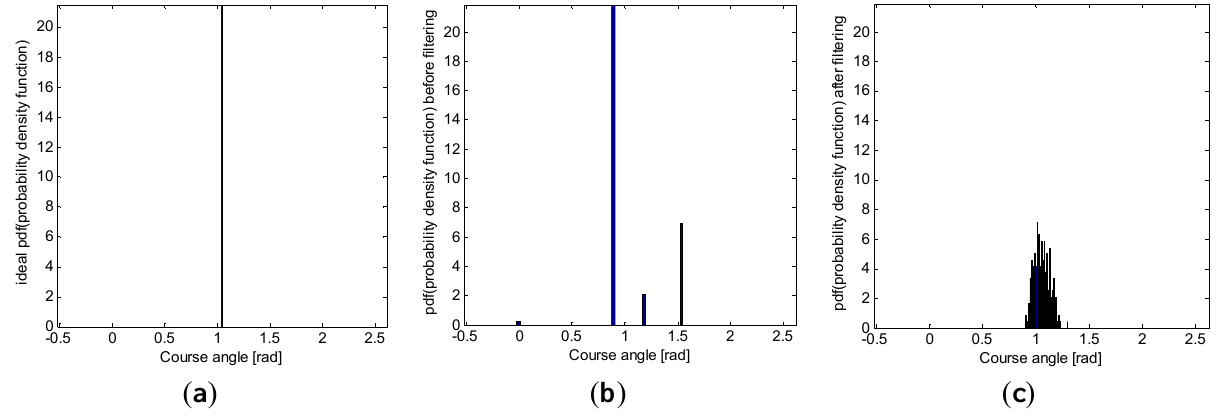
Figure 13. Heading angle ( θ ) histogram ( a ) of the estimated reference path; ( b ) of the raw GPS data; and ( c ) of the filtered data using the proposed Kalman filter. Data were obtained from a real onboard Navilock NL-402U GPS receiver, along a straight path with a 60° heading angle and at a constant speed of 5 km/h. The histogram has been normalized to have a unitary area, representing an approximation to the probability density function ( pdf ) of the heading angle statistical random variable.